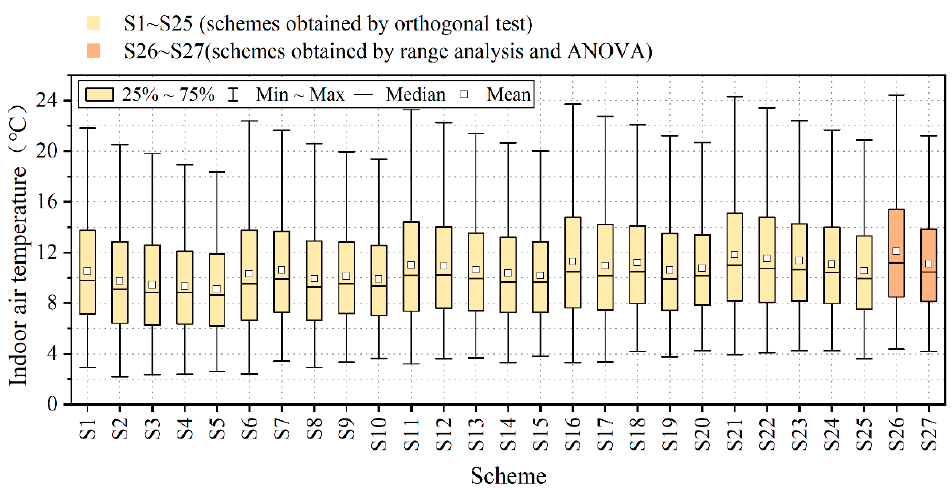
Figure 8. The indoor air temperature in January of 27 schemes.